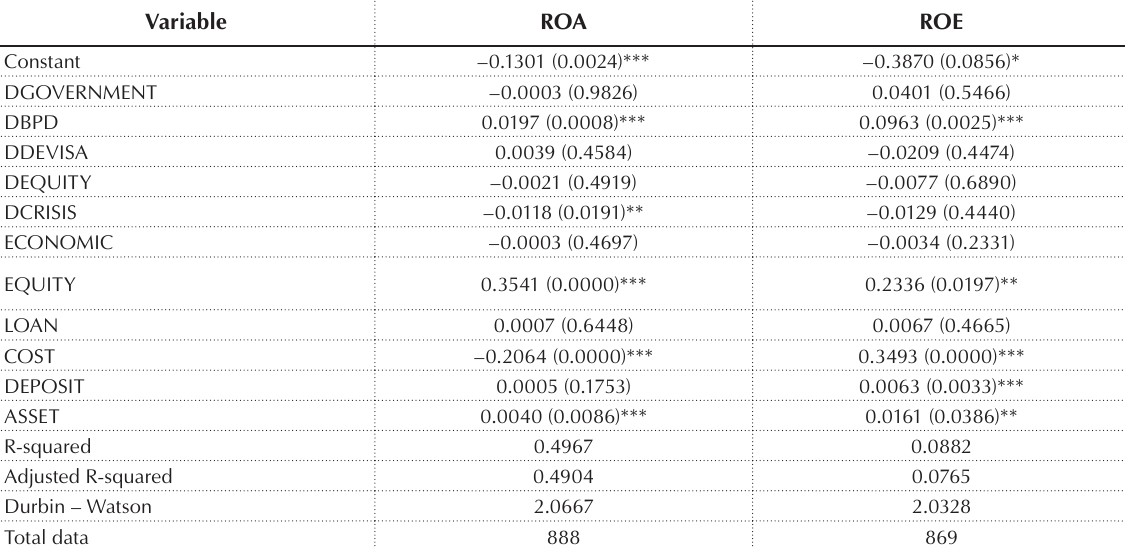
Table 1. (cid:100)(cid:346)(cid:286)(cid:3)(cid:396)(cid:286)(cid:400)(cid:437)(cid:367)(cid:410)(cid:400)(cid:3)(cid:381)(cid:296)(cid:3)(cid:437)(cid:400)(cid:349)(cid:374)(cid:336)(cid:3)(cid:410)(cid:346)(cid:286)(cid:3)(cid:39)(cid:62)(cid:94)(cid:3)(cid:373)(cid:286)(cid:410)(cid:346)(cid:381)(cid:282)